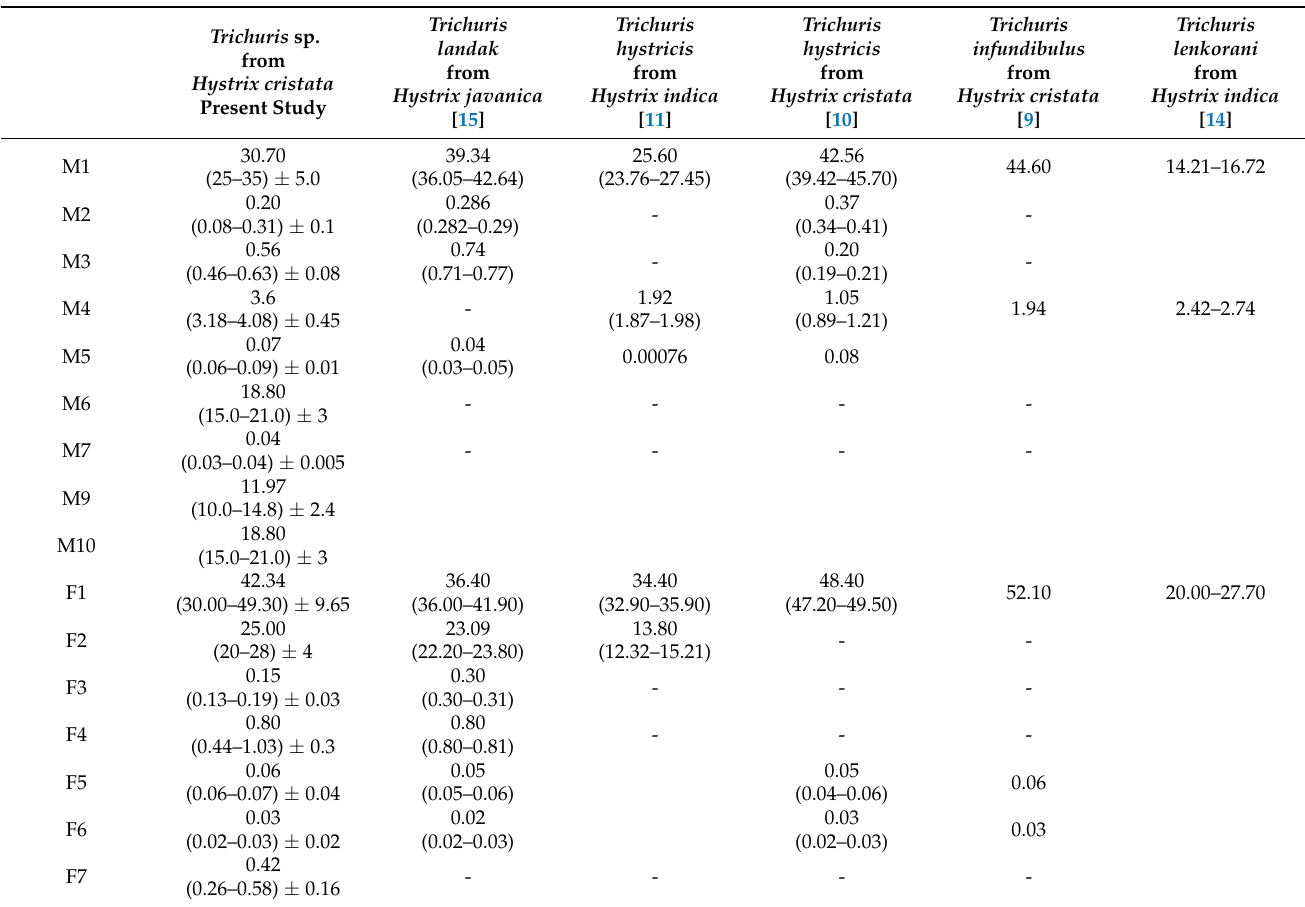
Table 2. Morphological data of male (M) and female (F) specimens of Trichuris from H. cristata analyzed in the present study and of other Trichuris species from Hystrix spp. (M1-F1: total length of body; M6-F2: length of esophageal part; M2-F3: width of body at level of esophagus end; M3-F4: width of posterior part; M4: length of spicule; M5: length of spicular sheat; F5: length of eggs; F6: width of eggs; F7: uterus–tail distance). All measurements are in mm. Arithmetic mean of measurements are indicated, with minimum and maximum in parenthesis and ± standard deviation (SD). Trichuris sp.